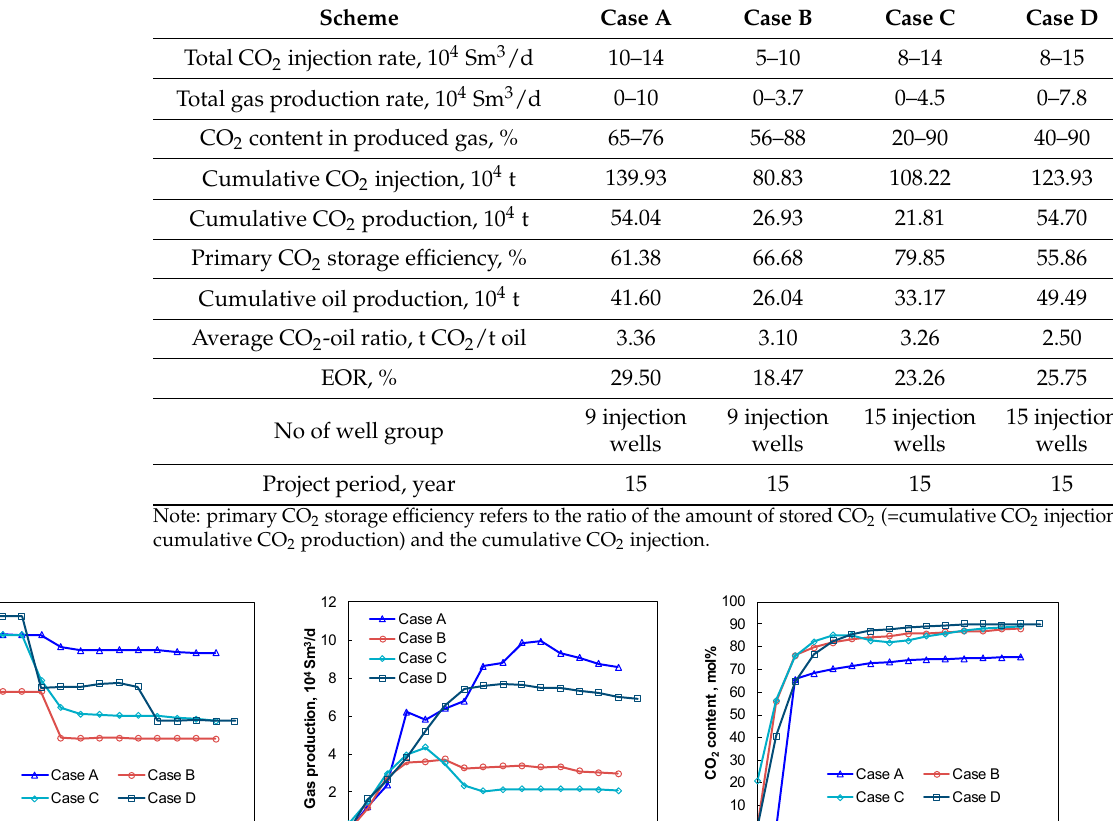
Table 4. Predicted results of four CO 2 flooding schemes for CO 2 EOR and storage project in XinJiang oilfield.